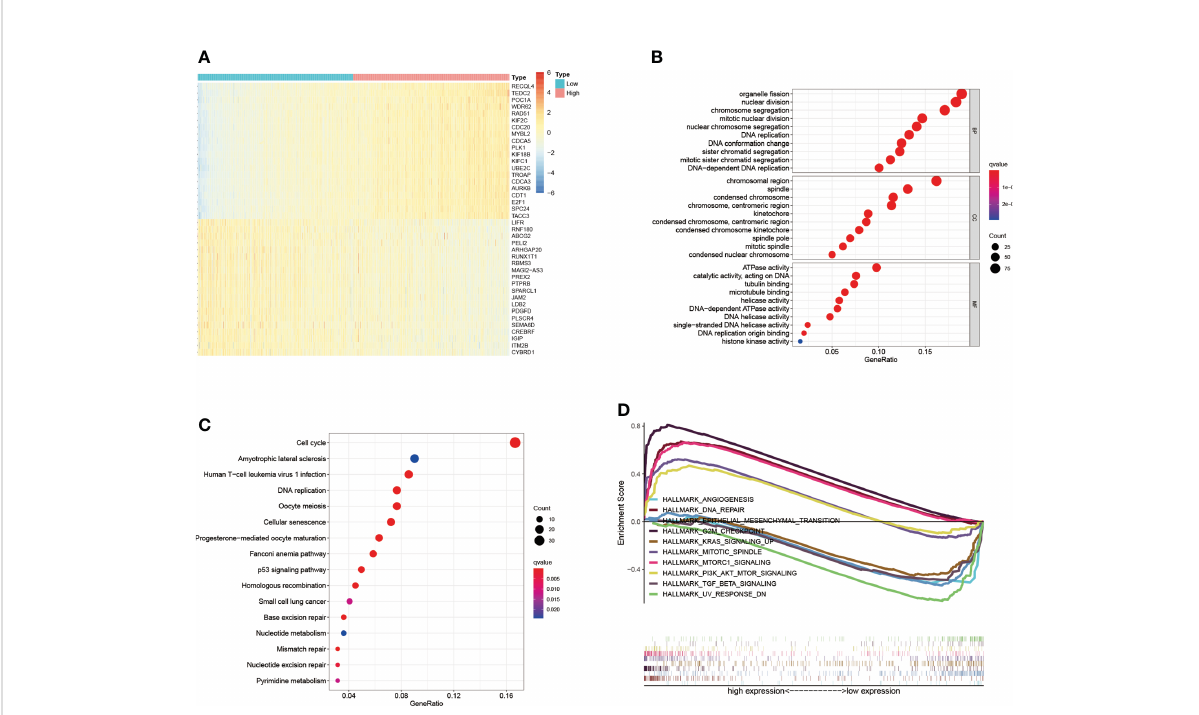
FIGURE 3 Co-expressed genes of PKMYT1 and function enrichment analysis. (A) The heatmap showed the top 40 genes strongly correlated with PKMYT1. (B, C) GO enrichment and KEGG enrichment analysis of genes co-expressed with PKMYT1. (D) GSEA analysis showed signi fi cant enrichments related to PKMYT1